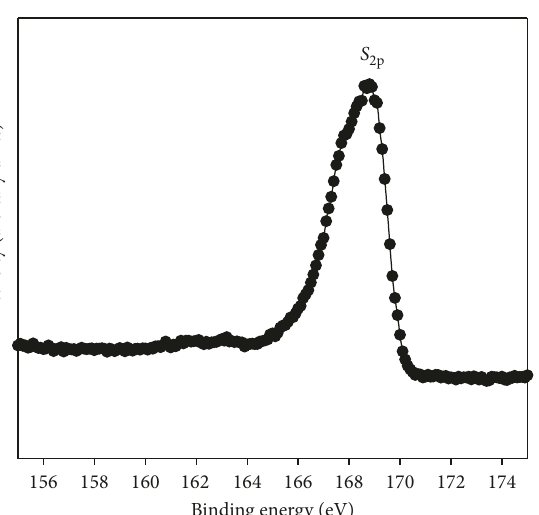
2p for the regenerated lateritic